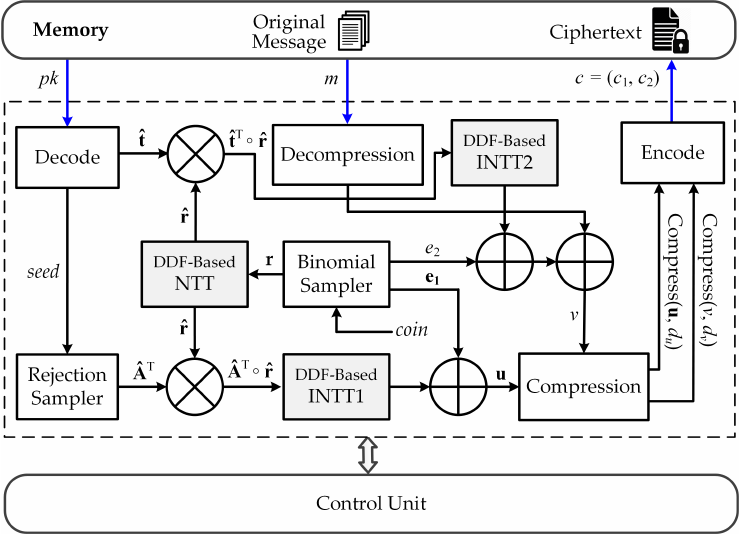
Figure 4. Proposed encryption architecture.